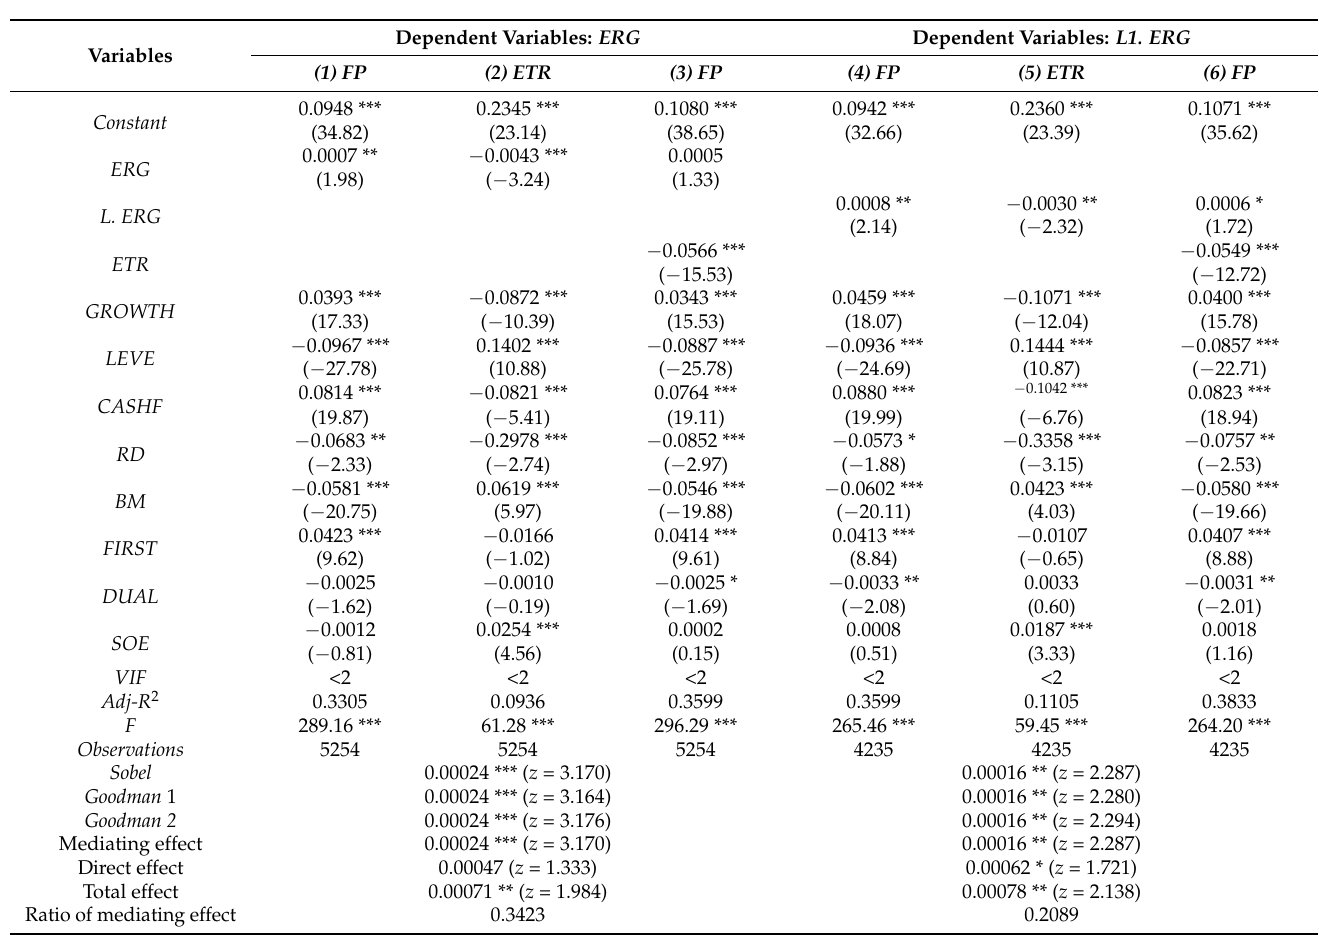
Table 5. Regression results (current period and lag phase